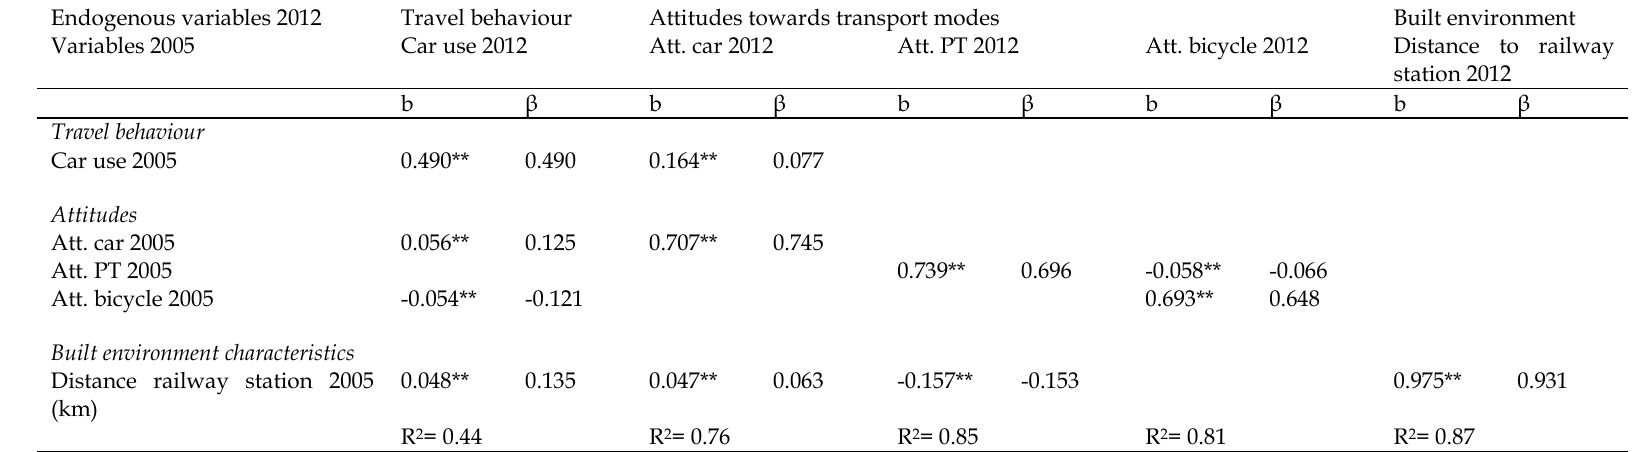
Table 2. Model 1 with endogenous variables only